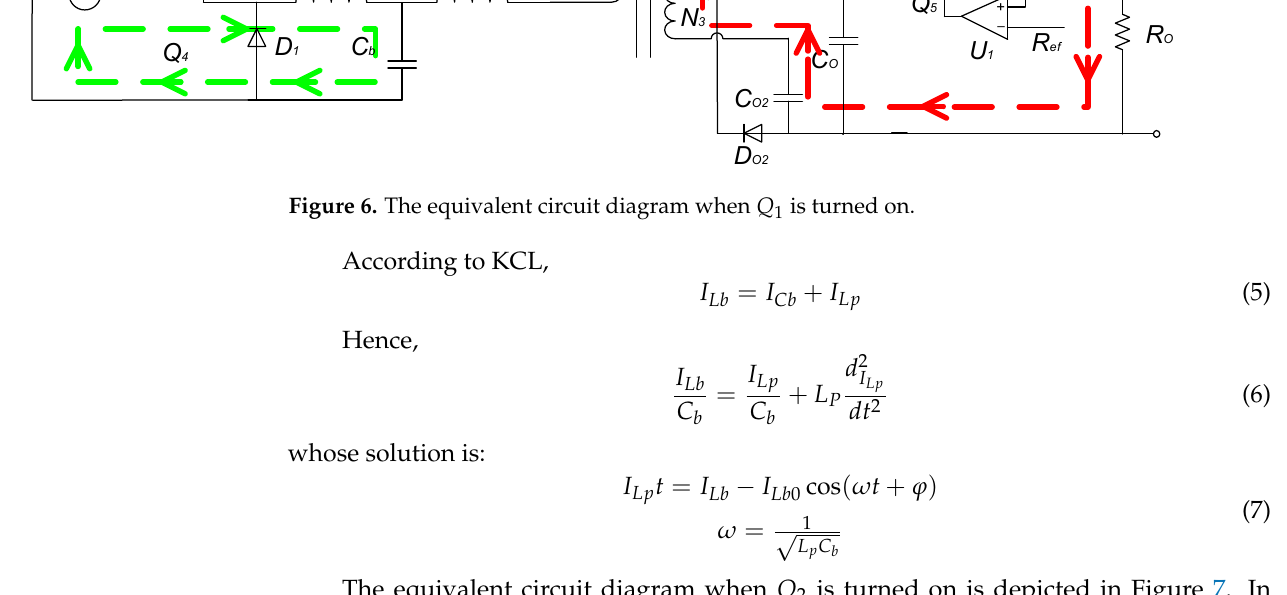
The equivalent circuit diagram when Q 2 is turned on is depicted in Figure 7. In Figure 7, the green and blue arrows indicate the direction of current flow on the primary side, the red arrows indicate the direction of current flow on the secondary side.